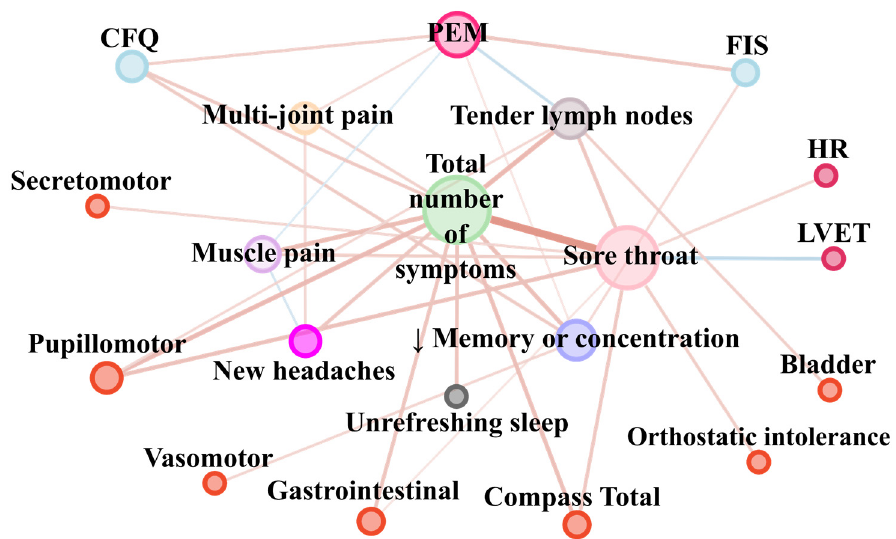
Figure 2. Network analysis of Fukuda symptoms’ coexistence with each other and fatigue scales, subjective and objective autonomic nervous system disturbance. Note: The variables were grouped according to categories illustrated by node colour. Each Fukuda criteria (post-exertional malaise (PEM) (hot pink), multi-joint pain (bisque), muscle pain (plum), new headaches (magenta), unrefreshing sleep (dark grey), ↓ memory or concentration (impaired memory or concentration (dark blue)), sore throat (pink), tender lymph nodes (auburn) and their total number (light green) are shown in the centre. Nodes indicating objective hemodynamic and autonomic parameters (HR—heart rate and LVET—left ventricular ejection time) are shown in cherry colour. Results of fatigue scales are shown in light blue (CFQ—Chronic Fatigue Scale, FIS—Fatigue Impact Scale). The total result of the Compass-31 scale (Compass Total), indicating subjective autonomic nervous system disturbances and divisions for components (secretomotor, pupillomotor, vasomotor, gastrointestinal, bladder, orthostatic intolerance), are denoted by bright red nodes. The size of the dots next to the variable names is continuously related to the number of statistically significant correlation coefficients with other variables. The colour of the edges denotes the trend of the correlation: blue indicates a negative correlation, while red indicates a positive correlation. Edge width and intensity of colour denote strength of relationship. Table 2. Symptom correlation in CFS